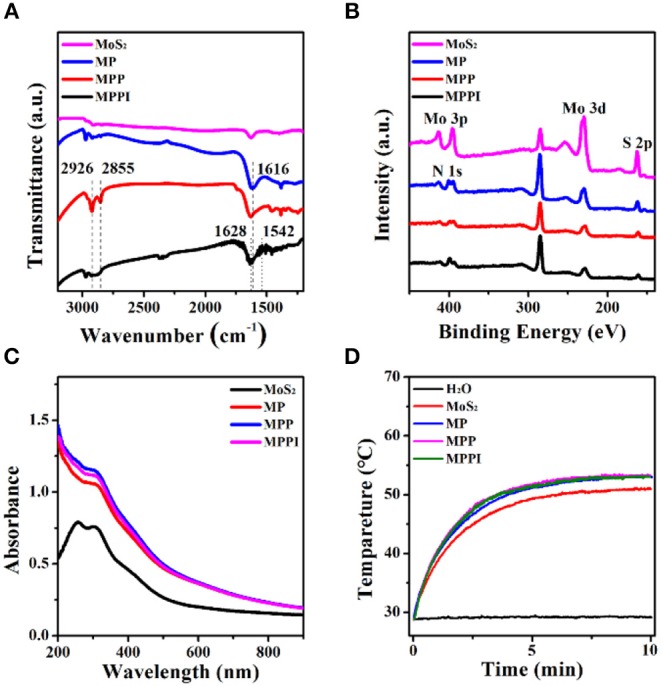
(A) Fourier transform infrared (FT-IR) spectra, (B) X-ray photoelectron spectroscopy (XPS) spectra, and (C) Ultraviolet-visible-near infrared (UV-Vis-NIR) absorption spectra of MoS2 NSs, MP NSs, MPP NSs, and MPPI NSs. (D) Photothermal heating curves of MoS2 NSs, MP NSs, MPP NSs, and MPPI NSs (MoS2: 30 μg/mL). All samples were irradiated under 785 nm laser at the power density of 0.43 W/cm2 for 10 min.